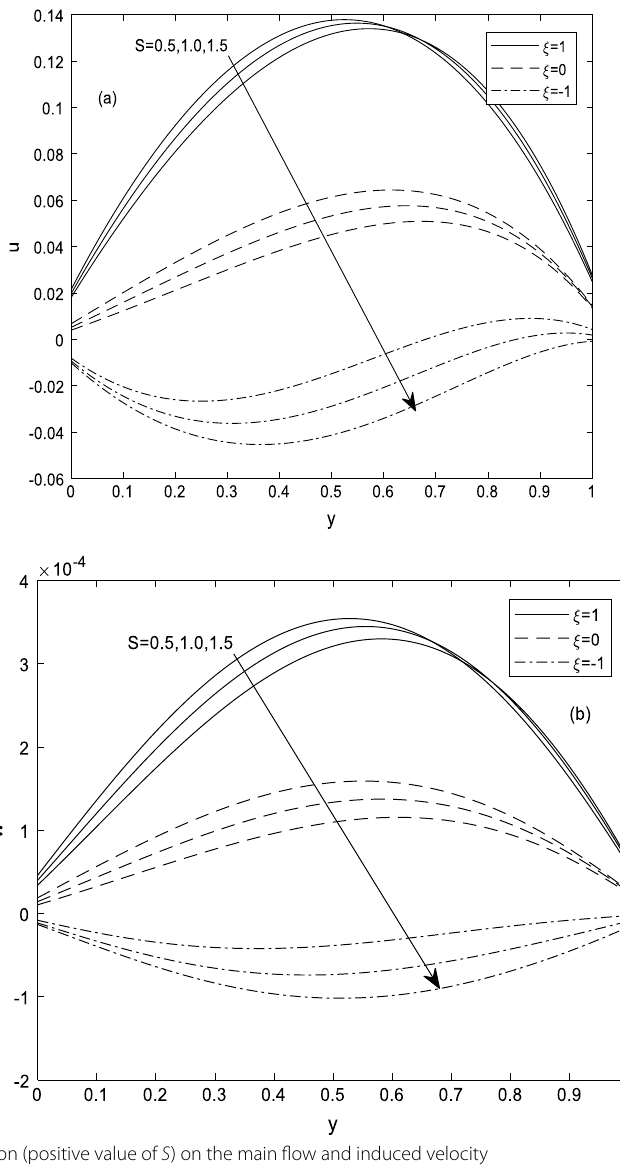
profiles, for β v Kn = 0.05, M = 2,ln = 1.667, β h = 0.10, β i = 3.0 and Pr = 0.71 . b v Kn = 0.05, M = 2,ln = 1.667, β h = 0.10, α e = 3.0 and Pr =